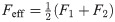
The free energy, F = −log Z, as a function of the interaction parameter U.(a) for N = K = 6 (b) for N = K = 5. (c) The combined free-energy Feff=12(F1+F2). The estimated values of the interaction, Uff and Umm [Eq (18)], are shown together with their corresponding error-bars. Both females and males are far from being neutral (green line, U = 0). In a single-sex environment females are more social than males.